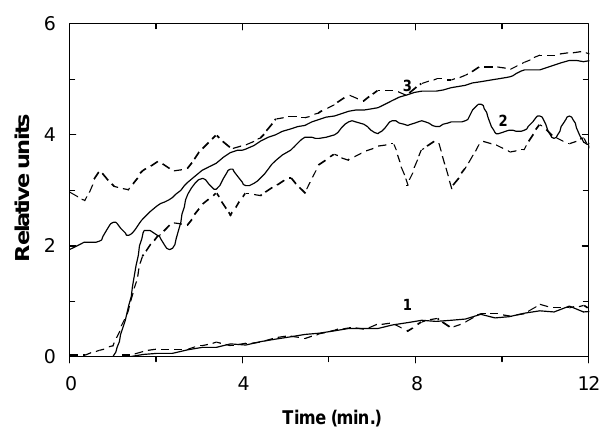
Figure 7. Observed changes with time of cloud medium liquid water content (1, g/m 3 ), concentration (2, 300 cm -3 ) and effective radius of cloud drops (3, µm) in the background experiment (solid curves) and at the introduction of salt powder with the mass concentration of 1.1 mg/m 3 (dashed curves).